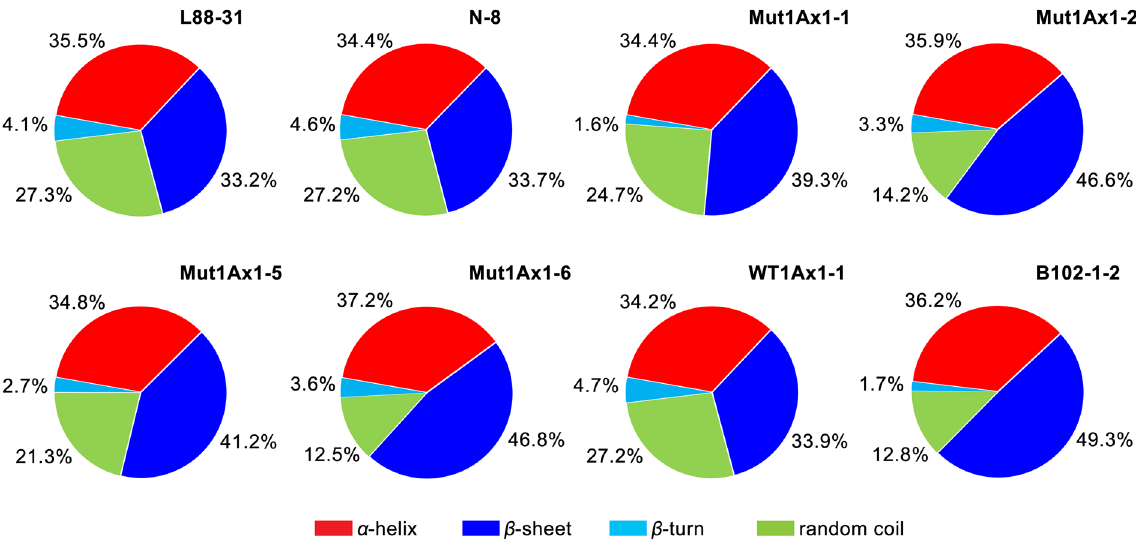
Figure 8. Effects of Mut1Ax1 on the secondary structure of gluten revealed by FT-IR. Values are given as the mean percentage of each secondary structure (n =